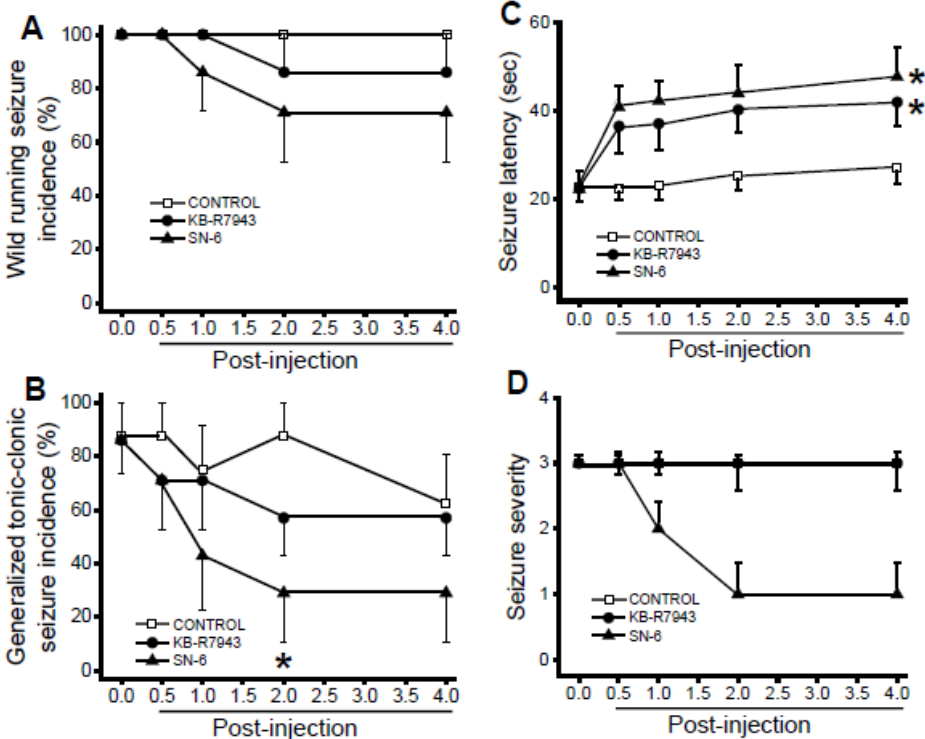
Figure 2. Effects of acute SN-6 or KB-R7943 treatment at the dose of 1 mg/kg on the occurrence of acoustically evoked alcohol withdrawal-induced seizure (AWS) susceptibility. The putative seizure suppressive effects of an inhibitor of NCX1 rev (SN-6, 1 mg/kg, p.o.) and NCX3 rev (KB-R7943, 1 mg/kg, p.o.) were evaluated at different posttreatment time points of 0.5-, 1-, 2-, and 4-h in rats exhibiting AWSs. ( A ). Both SN-6 and KB-R7943 treatments did not considerably reduce the incidence of WRSs component of AWSs. ( B ). SN-6 (but not KB-R7943) significantly reduced the incidence of GTCSs component of AWSs by the 2nd h post injection. ( C ). Both SN-6 and KB-R7943 treatments did not considerably delay the onset of seizure. ( D ). SN-6 did not considerably reduce the AWSs severity, while KB-7943 had no effect. Data from the incidence of WRSs and GTCSs are represented as mean percentage (%) ±SEM, Fisher’s Exact test was used for analysis. The seizure latency data are presented as mean ±SEM, and two-way ANOVA followed by Bonferroni post hoc correction was used for analysis. The seizure severity data were represented as median score ±SEM, and the Kruskal-Wallis test followed by Dunn’s post hoc correction was used for analysis. The summary of data was obtained from eight rats in the control-treated group and seven rats per group when SN-6 or KB-R7943 was used. * p < 0.05.